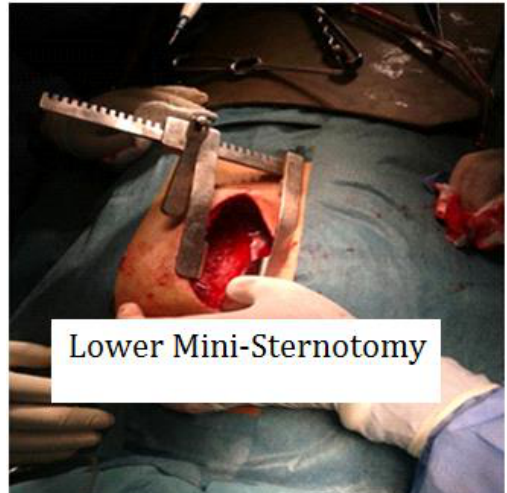
Figure 1: An operative photograph showing LMS approach.